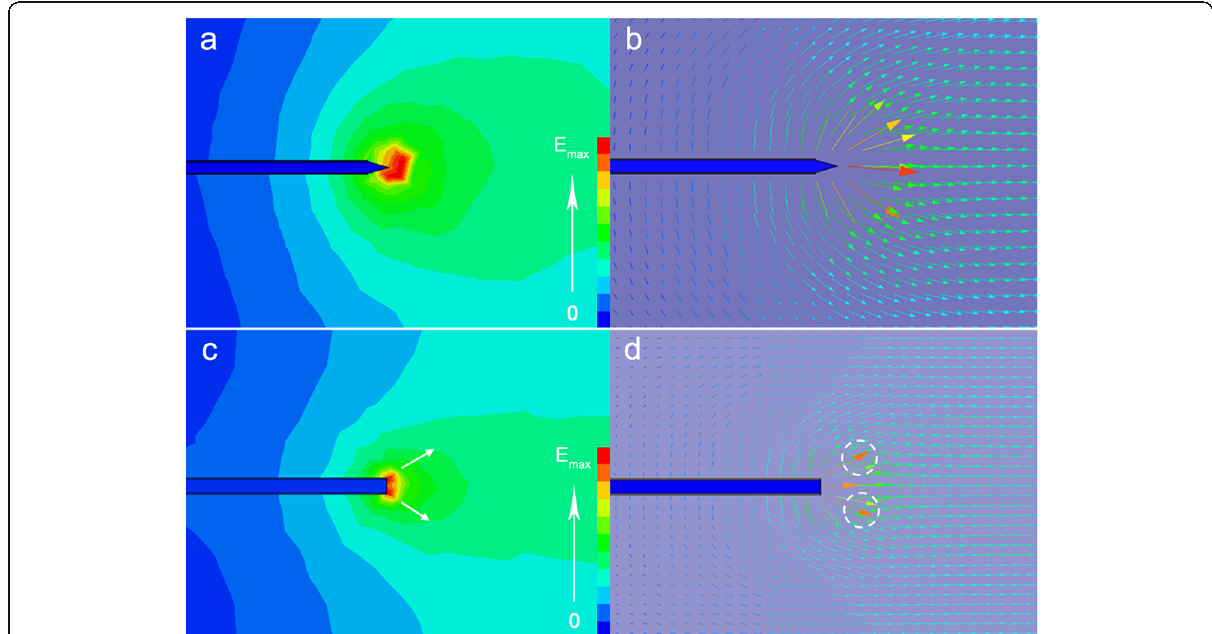
Fig. 2 a The electrical field distribution and b the velocity vector diagram around the needle tip (protruding droplet exists); c the electrical field distribution and d the velocity vector diagram around the needle tip (no protruding droplet